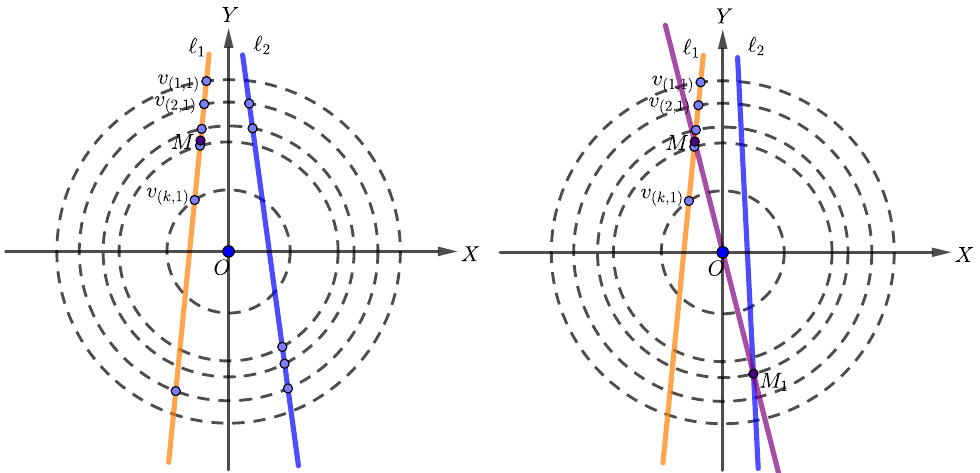
Figure 3. The construction for the convex configuration of V when ( left ) max { m 1 , . . . , m k } = 4 and ( right ) max { m 1 , . . . , m k } = 2 or